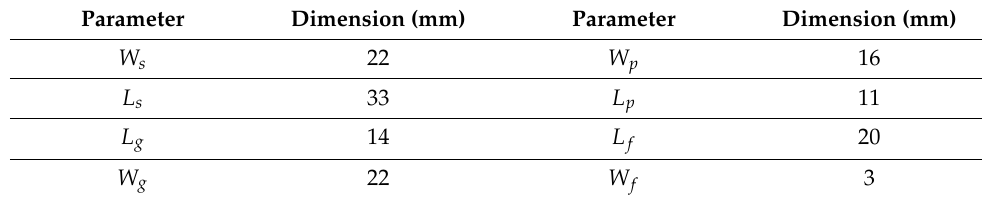
Figure 2. ( a ) The conventional rectangular shape and ( b ) Its simulated reflection coefficient re- sponse. Table 1. The initial dimensions of the proposed antenna. Table 1. The initial dimensions of the proposed antenna.